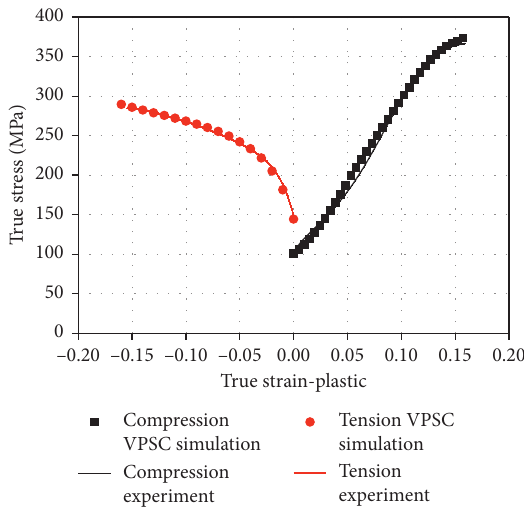
Figure 4: Correlation between experimental stress–strain and VPSC simulation results at room temperature. Table 1: Hardening parameters of slip and twin systems in the simulation of Mg alloy under monotonic loading.